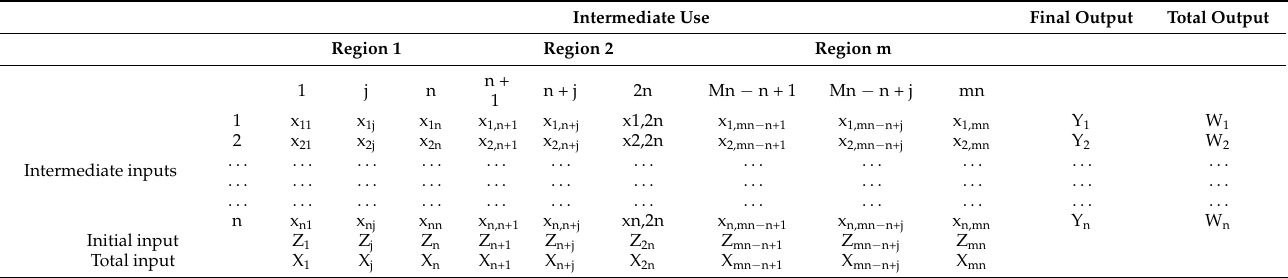
Table 1. Schematic outline of city-level MRIO table. Intermediate Use Final Output Total